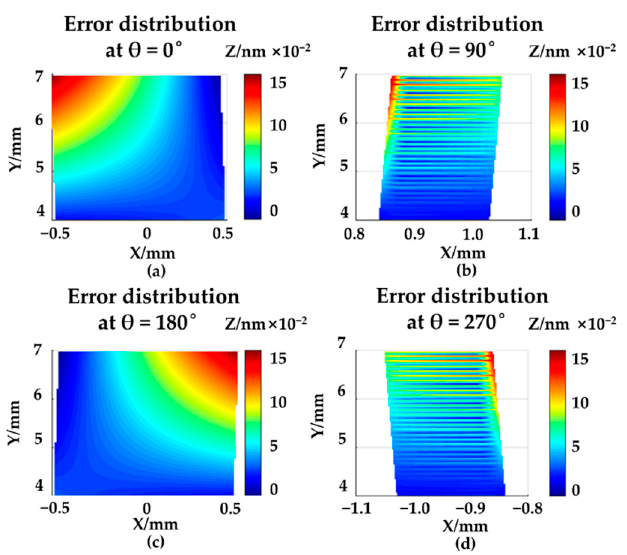
Figure 8. The error distribution in XOY plane after clamping-error compensation in simulation: ( a ) θ = 0°; ( b ) θ = 90°; ( c ) θ = 180°; ( d ) θ = 270°.